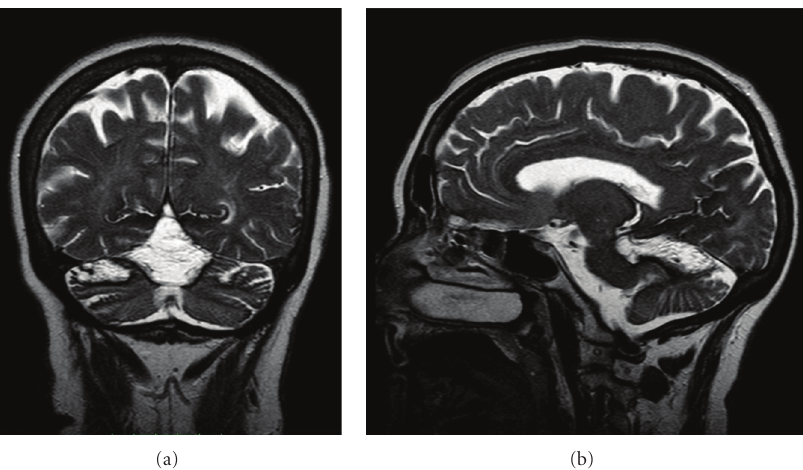
Figure 1: The coronal (a) and parasagittal (b) T2-ponderation MRI from patient 1 show a large clastic lesion over the vermis, marked cerebellar atrophy, and iron-related hypointensities around cerebellar hemispheres and